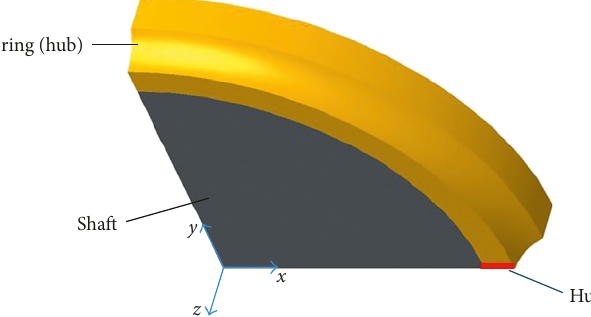
Figure 5: 3D model of press fit joint.